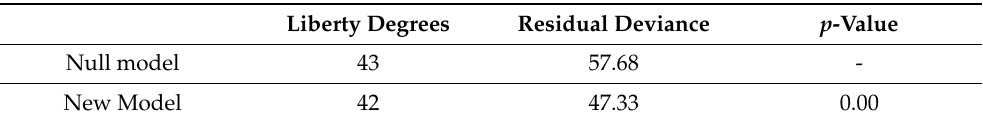
Table 8. Deviance analysis comparing the null model (only with the intercept) with the new model (with the co-variable Family